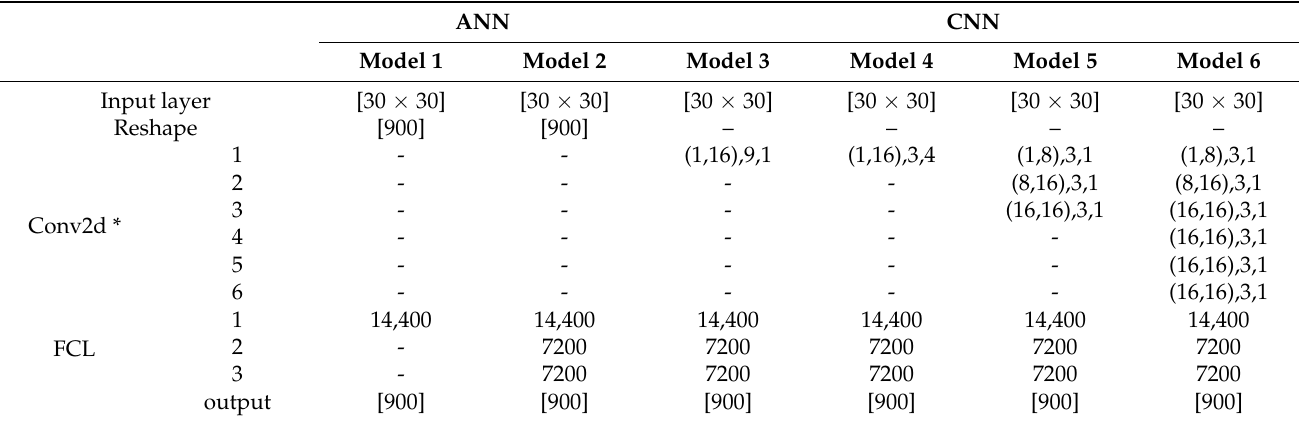
Table 5. Architecture of models in Group B.